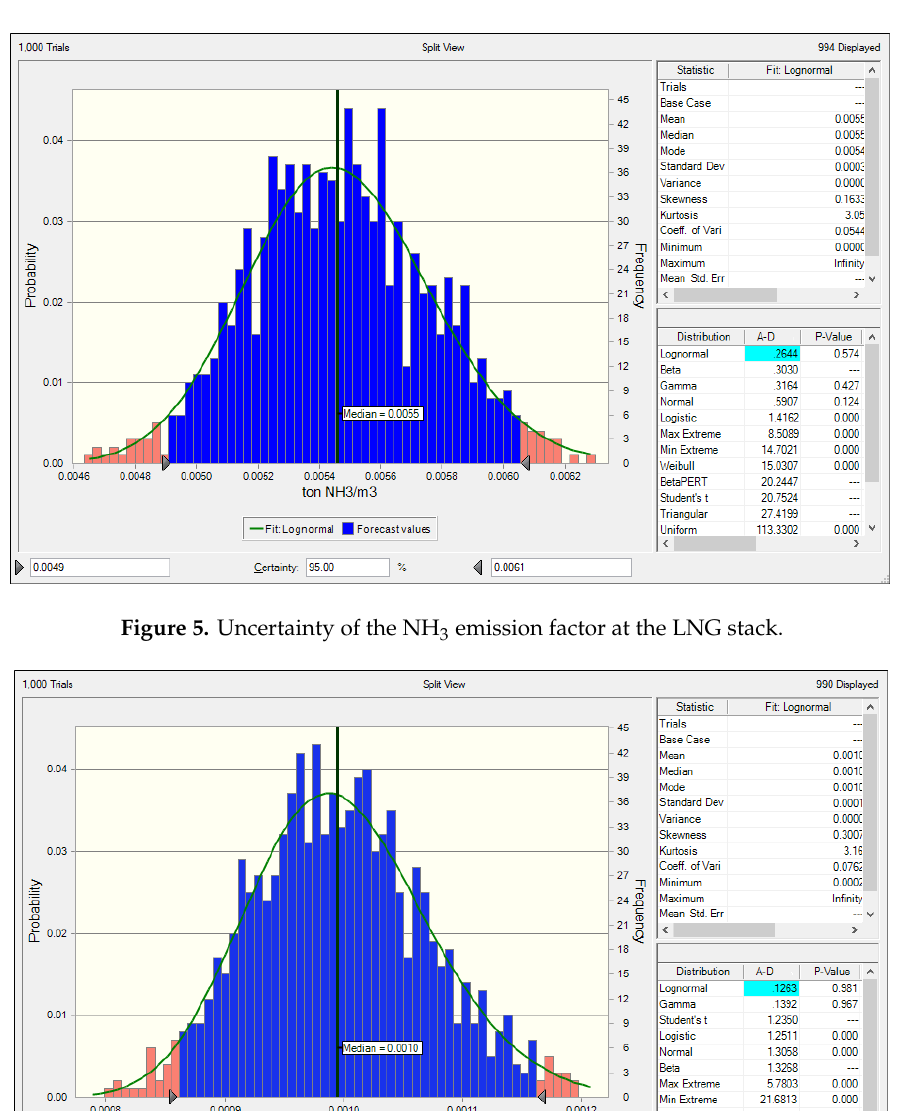
Figure 4. The comparison of NH 3 EF (Emission Factor) for NH 3 emissions at LNG power plants.